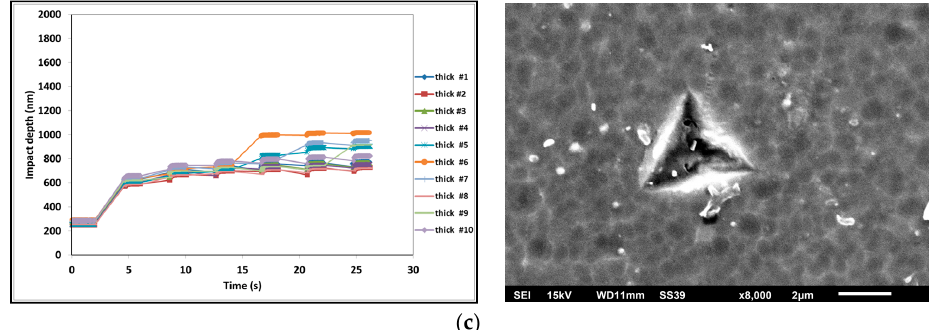
Figure 3. Short-term impact fatigue fracture resistance data at 20 mN, 30 s for the studied coatings: